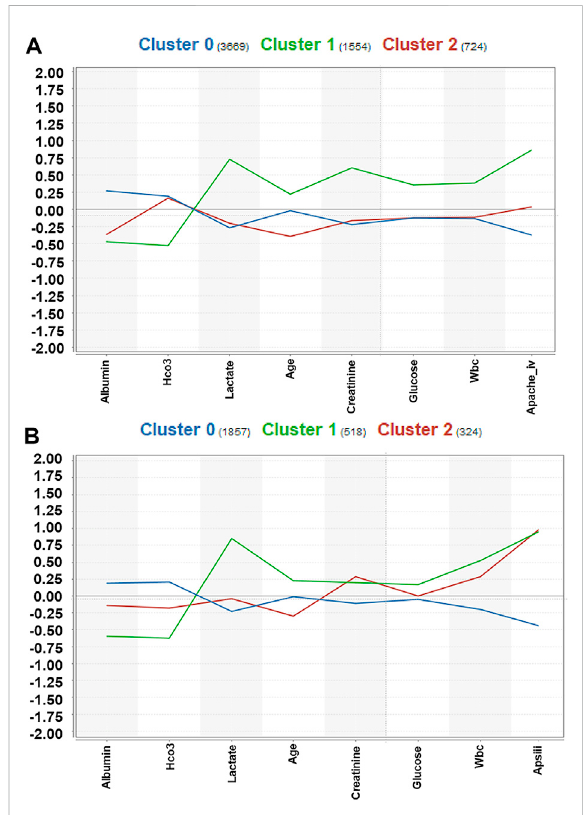
FIGURE 6 Centroid chart visualization of phenotype assignments by K- means in sepsis-associated ARDS. The laboratory indices were standardized, and the median laboratory indices differed between phenotypes. (A) : Centroid chart visualization of phenotype assignments by K-means in the eICU derivation cohort. There were three phenotypes, Clusters 0, 1, and 2, with 3669, 1554, and 724 patients respectively. (B) : Centroid chart visualization of phenotype assignments by K-means in the MIMIC-IV validation cohort. There were three phenotypes, Clusters 0, 1, and 2, with 1857, 518, and 324 patients